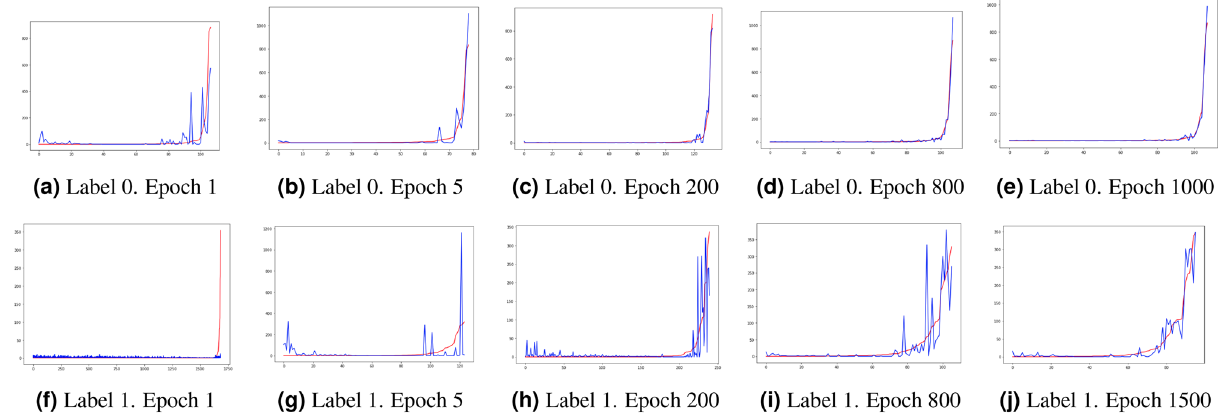
Figure 6. Comparison of synthetic (blue) and real (red) data distributions using GAN generators for label 0 ( a – e ) and label 1 ( f – j ) in different epochs (1, 5, 200, 800 and 1500). The 4-dimensional vector has been flattened into by sorting by frequency in ascending order on the x -axis.